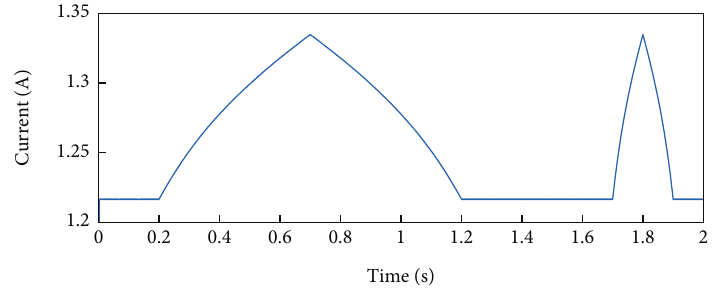
Figure 19: Response of the PVE to the EN 50530 irradiance (current).